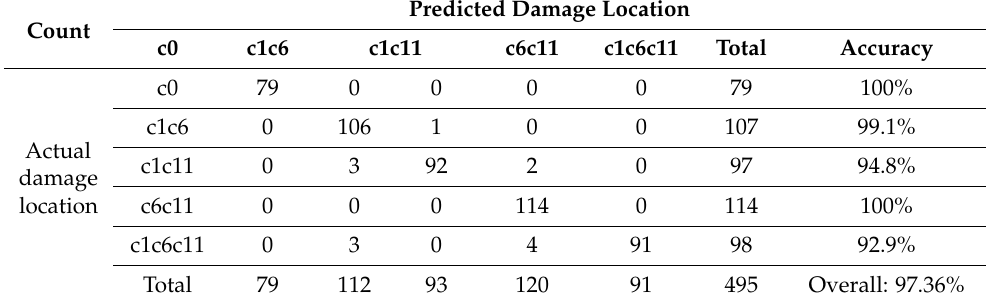
Table 4. The test results.